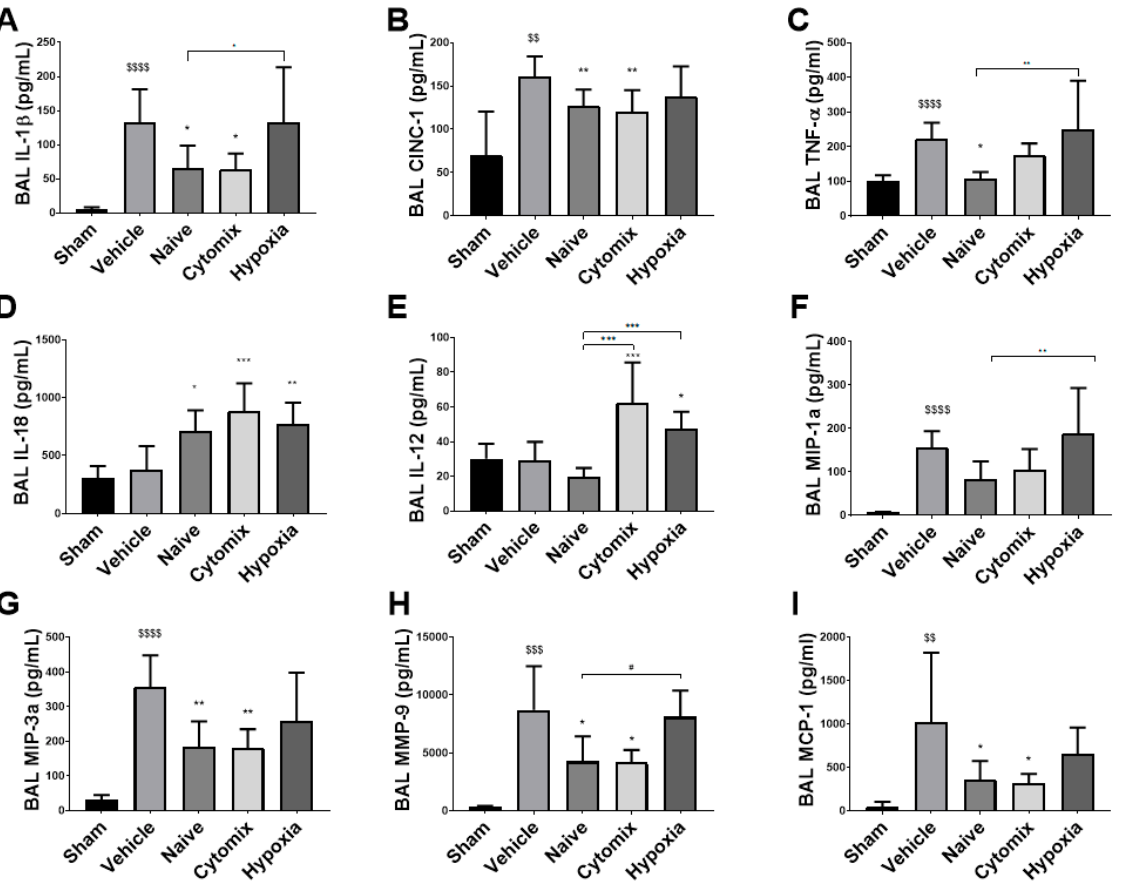
Figure 4. The inflammatory cytokines IL-1 β , CINC-1, and TNF- α present in the BAL were reduced in animals treated with naïve and cytomix-pre-activated MSCs compared to the vehicle control ( A – C ). Interleukin-18 was significantly increased in all MSC-treated groups compared to the control ( D ). Interleukin-12 was significantly increased in the cytomix and hypoxia MSC groups compared to the control ( E ). MIP-1 α was reduced by naïve and cytomix MSCs ( F ), and MIP-3 α was significantly reduced by naïve and cytomix-pre-activated MSCs compared to the control ( G ). MMP-9 and MCP-1 were significantly reduced in the naïve and cytomix-pre-activated MSC groups ( H , I ). IL = interleukin; CINC-1 = cytokine-induced neutrophil chemoattractant 1; TNF- α = tumor necrosis factor alpha; MIP = macrophage inflammatory protein; MMP = matrix metalloprotease; MCP = monocyte chemotactic protein. Columns represent means. Error bars represent SDs. *, **, *** = p ≤ 0.05, 0.01, 0.001 with respect to the vehicle control. $$, $$$, $$$$ = p ≤ 0.01, 0.001, 0.0001 with respect to the sham group. # = p ≤ 0.05 with respect to other treatment. N =